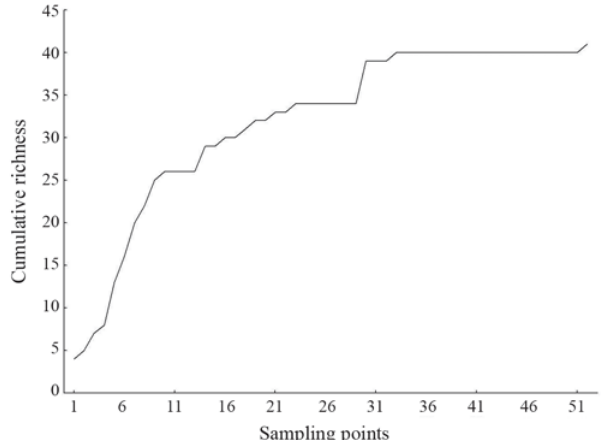
Fig. 3. Species accumulation curve for sampling points in upper rio Capivari basin.